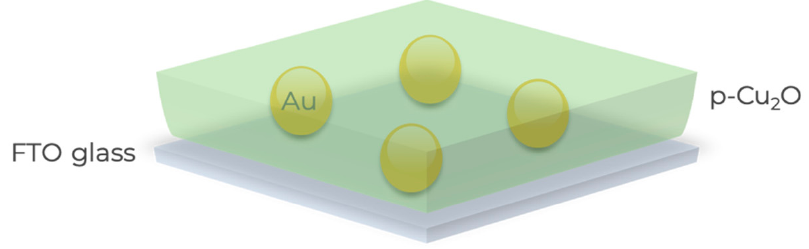
Scheme 1. Schematic representation of FTO/Au NPs/p-Cu 2 O film